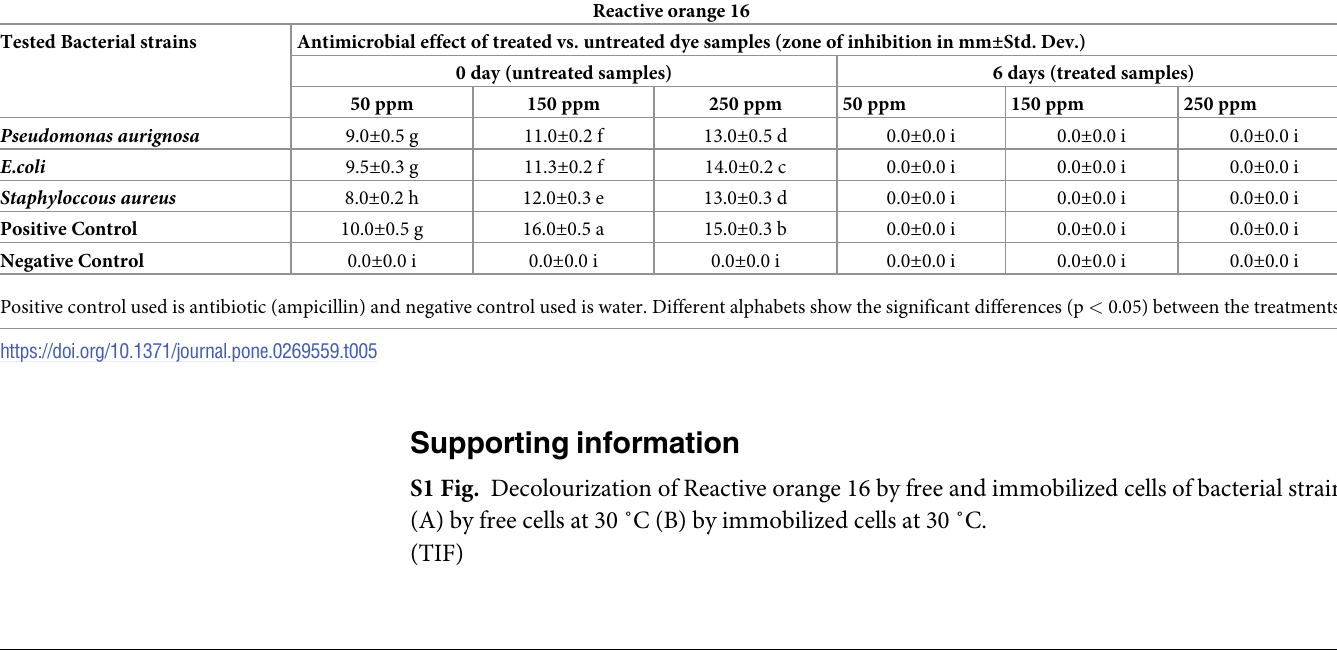
Table 5. Antimicrobial activity of treated and untreated Reactive orange 16 samples against bacteria. Tested Bacterial